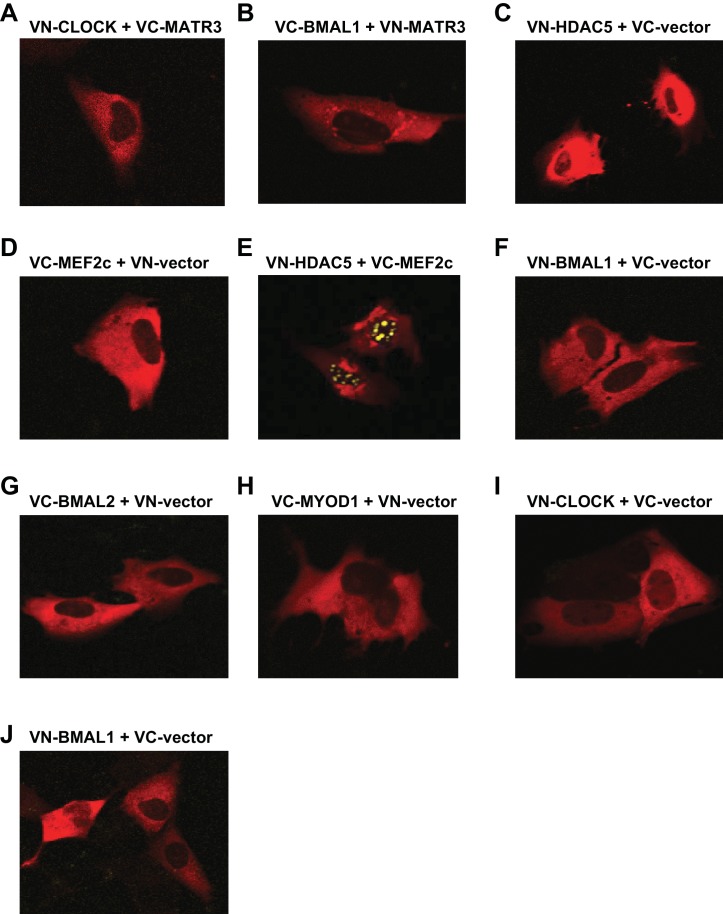
Representative control images for BiFC experiments in C2C12 myotubes.Interactions were visualized in C2C12 cells by bimolecular fluorescence complementation assay (BiFC). (A) VN-HDAC5 and VC-MATR3; (B) VC-BMAL1 and VN-MATR3; (C) VN-HDAC5 and VC-vector; (D) VC-MEF2C and VN-vector; (E) VN-HDAC5 and VC-MEF2C; (F) VN-BMAL1 and VC-vecctor; (G) VC-BMAL2 and VN-vector; (H) VC-MYOD1 and VN-vector; (I) VN-CLOCK and VC-vector; (J) VN-BMAL1 and VC-vector.